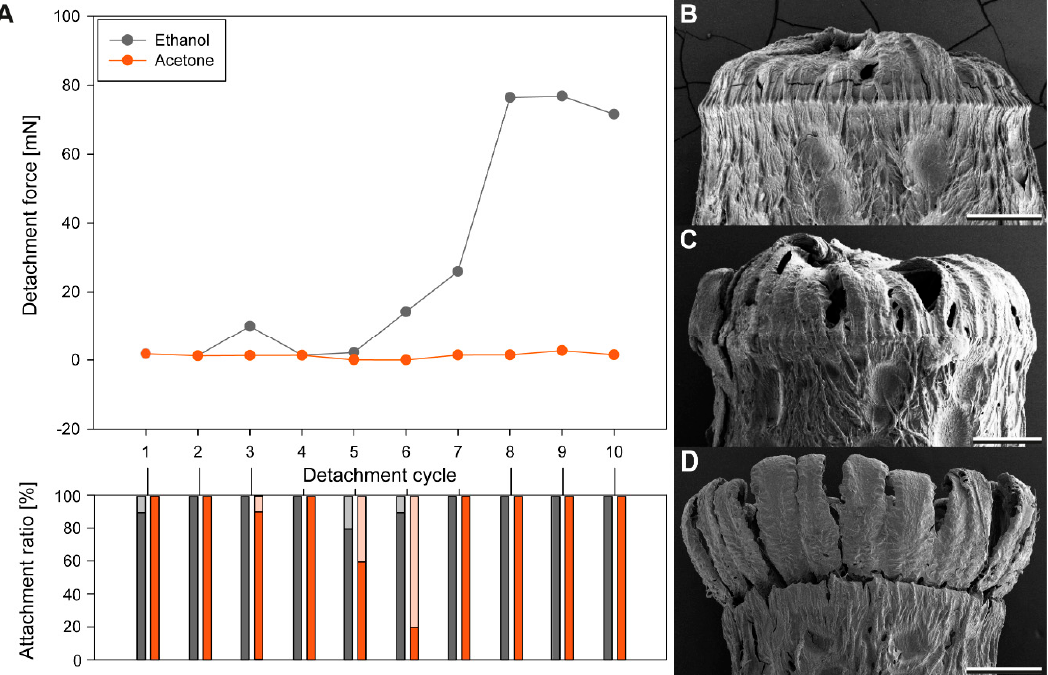
Figure 3. Solvent influence on sequential detachment of freshly laid (dry) eggs: ( A ) Line plots (above) and the corresponding attachment ratio (below) for sequential measurements of eggs exposed to ethanol and acetone; ( B – D ) Scanning electron micrographs of the response of the pinnae to solvent exposition: ( B ) Inhibited expansion; ( C ) Moderate expansion; ( D ) Expansion; Scale bars: 500 μ m.